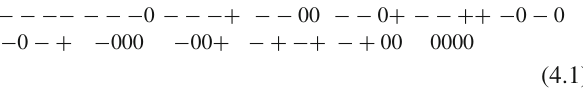
√ Table 4 Values of s U (in TeV) for all the helicity amplitudes